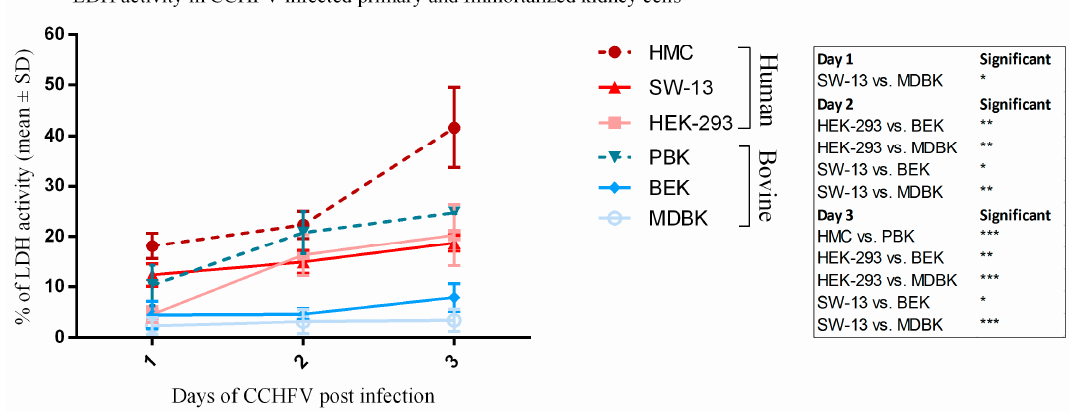
Figure 5. Cell cytotoxicity measured by LDH assay in CCHFV infected immortalized and primary human and bovine kidney cells at di ff erent time points. Measurements were taken in triplicate. The mean percentage cytotoxicity was seen at 0.1 MOI of virus infection at one, two and three-days post-CCHFV infection in immortalized kidney cells (BEK and MDBK). Dashed lines indicate primary, continuous lines indicate immortalized cell lines. In immortalized human cell lines at three dpi the cytotoxicity level reached an average of 19.51% compared to an average of 5.65% in immortalized bovine kidney cells and 41.62% in primary human kidney cells compared to 24.80% in the primary bovine kidney cells.